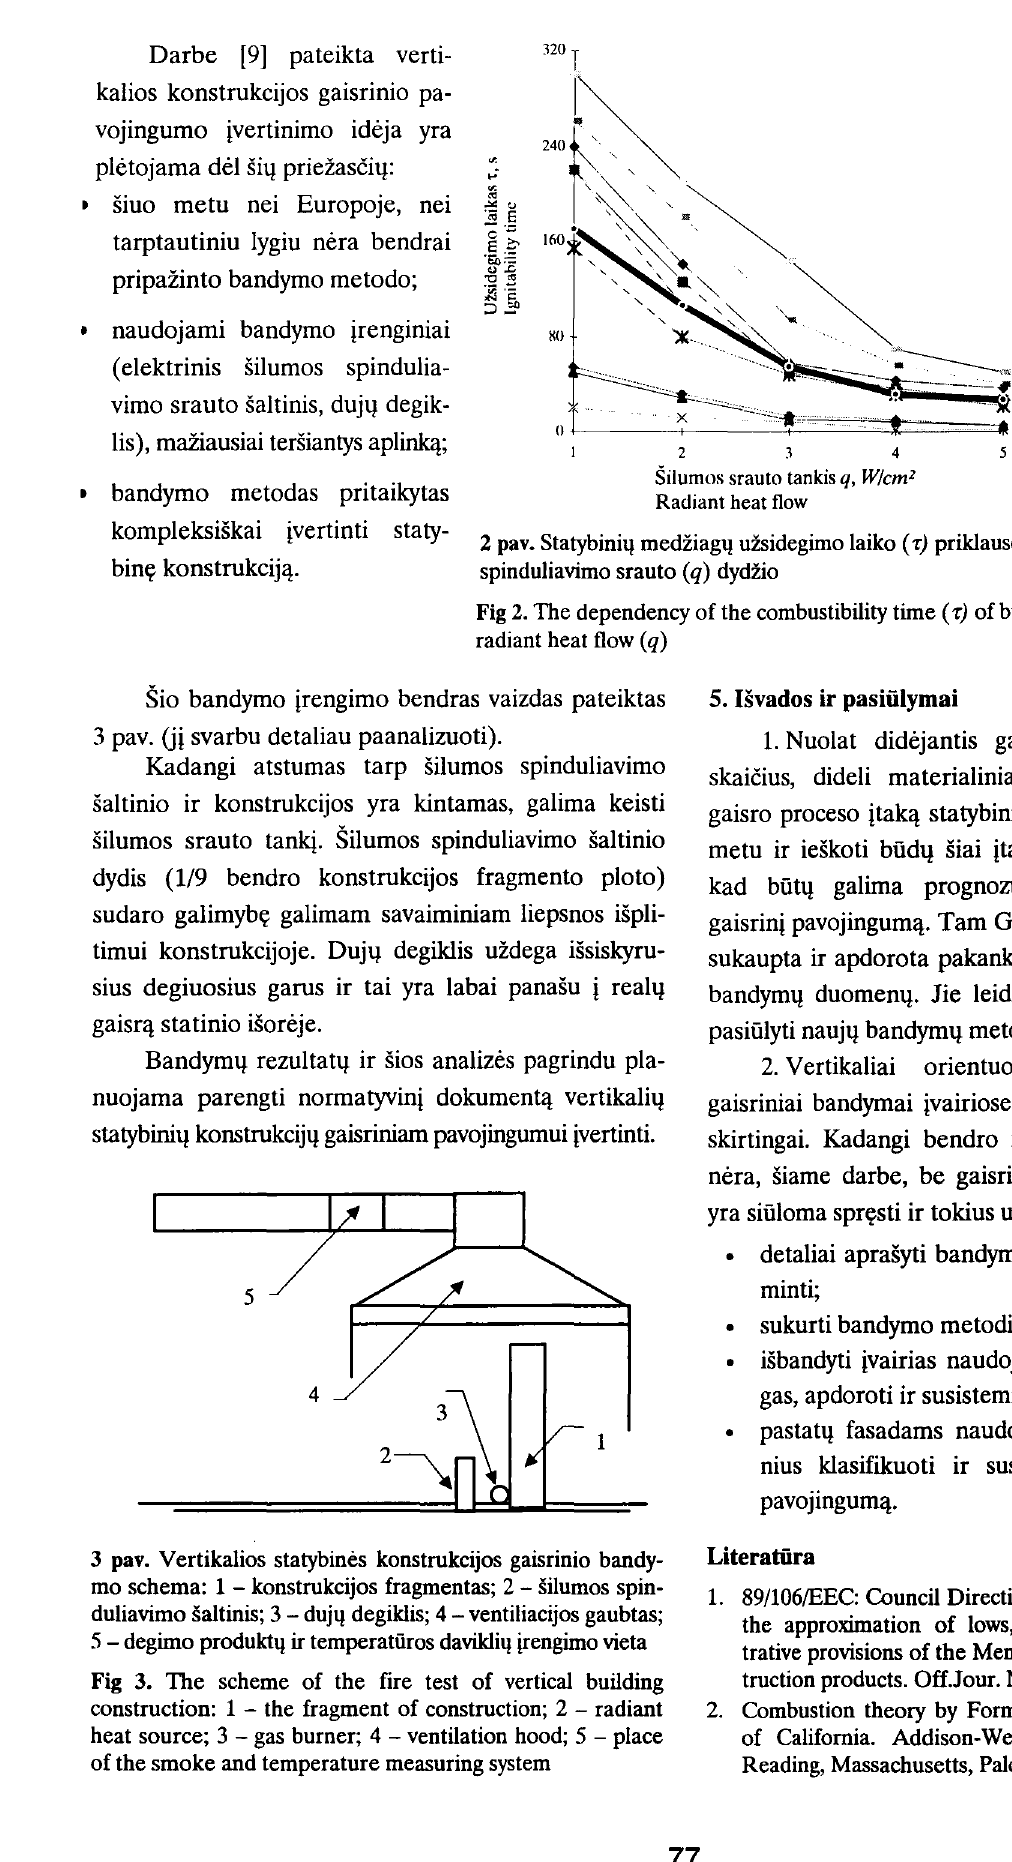
rna schema: 1 - konstrukcijos fragmentas; 2 - silumos spin duliavimo saltinis; 3 - dujq degiklis; 4 - ventiliacijos gaubtas; Fig 3. The scheme of the fire test of vertical building construction: 1 - the fragment of construction; 2 -